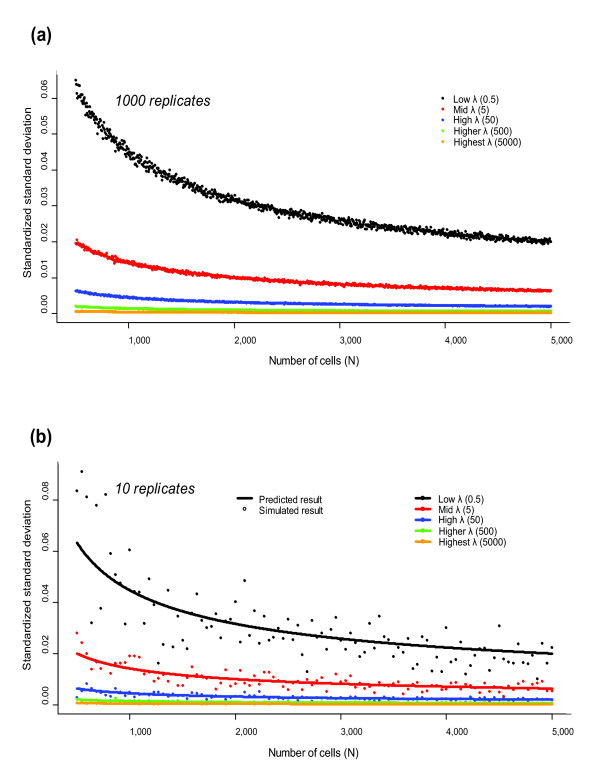
(a) Trends in variability as the size of the cell population increases are shown for five different levels of λ, representing 'high', 'medium' and 'low' levels of gene expression. Variability is shown by the standardized standard deviation (a measure of variance) of simulated gene expression values calculated across 1,000-fold replicated populations of cells, and has been standardized by average gene expression. The standardized variance is another way of showing how the variance changes with respect to the number of cells in our virtual population. Higher values will always be associated with higher variance so we standardized by the mean value to see the true behavior of the system. As we expect the variance to follow the analytic solution λN
 MathType@MTEF@5@5@+=feaafiart1ev1aaatCvAUfeBSjuyZL2yd9gzLbvyNv2Caerbhv2BYDwAHbqedmvETj2BSbqee0evGueE0jxyaibaiKI8=vI8tuQ8FMI8Gi=hEeeu0xXdbba9frFj0=OqFfea0dXdd9vqai=hGuQ8kuc9pgc9s8qqaq=dirpe0xb9q8qiLsFr0=vr0=vr0dc8meaabaqaciGacaGaaeqabaqadeqadaaakeaadaWcaaqaaiabeU7aSbqaaiaad6eaaaaaaa@35C4@, standardizing the variance by the mean (for a Poisson random variable, the mean is also λ) will give overall data that decays according to 1N
 MathType@MTEF@5@5@+=feaafiart1ev1aaatCvAUfeBSjuyZL2yd9gzLbvyNv2Caerbhv2BYDwAHbqedmvETj2BSbqee0evGueE0jxyaibaiKI8=vI8tuQ8FMI8Gi=hEeeu0xXdbba9frFj0=OqFfea0dXdd9vqai=hGuQ8kuc9pgc9s8qqaq=dirpe0xb9q8qiLsFr0=vr0=vr0dc8meaabaqaciGacaGaaeqabaqadeqadaaakeaadaWcaaqaaiaaigdaaeaacaWGobaaaaaa@34CB@. We chose to represent the standardized standard deviation (the square root transformation of the variance) because this quantity will follow the analytic solution λN/λ=1Nλ
 MathType@MTEF@5@5@+=feaafiart1ev1aaatCvAUfeBSjuyZL2yd9gzLbvyNv2Caerbhv2BYDwAHbqedmvETj2BSbqee0evGueE0jxyaibaiKI8=vI8tuQ8FMI8Gi=hEeeu0xXdbba9frFj0=OqFfea0dXdd9vqai=hGuQ8kuc9pgc9s8qqaq=dirpe0xb9q8qiLsFr0=vr0=vr0dc8meaabaqaciGacaGaaeqabaqadeqadaaakeaadaWcgaqaamaakaaabaWaaSaaaeaacqaH7oaBaeaacaWGobaaaaWcbeaaaOqaaiabeU7aSjabg2da9maalaaabaGaaGymaaqaamaakaaabaGaamOtaiabeU7aSbWcbeaaaaaaaaaa@3C26@ and, therefore, we can represent different curves for different values of λ. (b) Trends in variability as the cell population size changes are highlighted for a simulated example with a lower (ten-fold) degree of replication. The standardized variance of simulated gene expression values is shown by dots, and the standardized variance given by our analytical model is shown by the bold line. This suggests that, even with a moderate number of replicates, we should be able to observe a distinct effect dependent on the gene expression level.